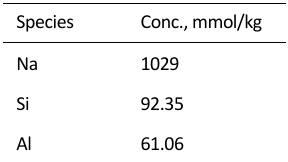
Table 3. Bulk Na, Si, and Al concentrations in sample reactor.